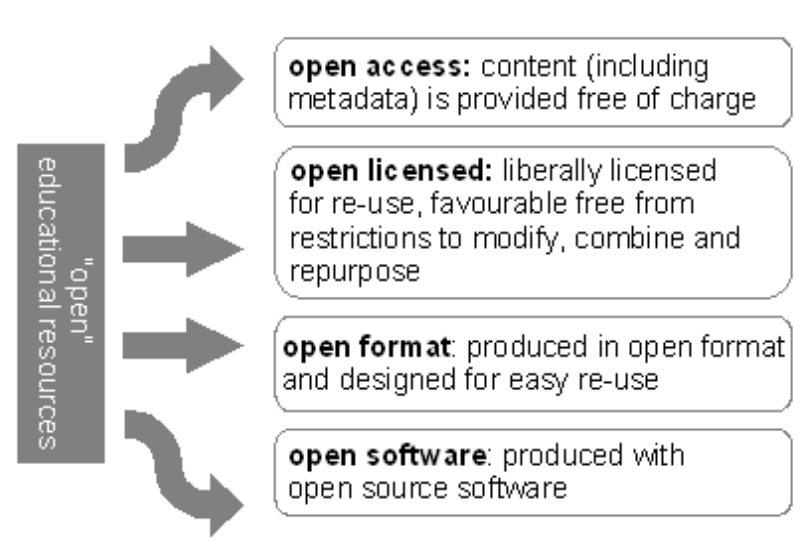
Figure 1 . The meaning of open in open educational